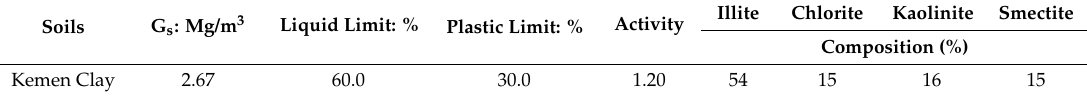
Table 1. Basic physical properties and mineralogical composition of Kemen clay.